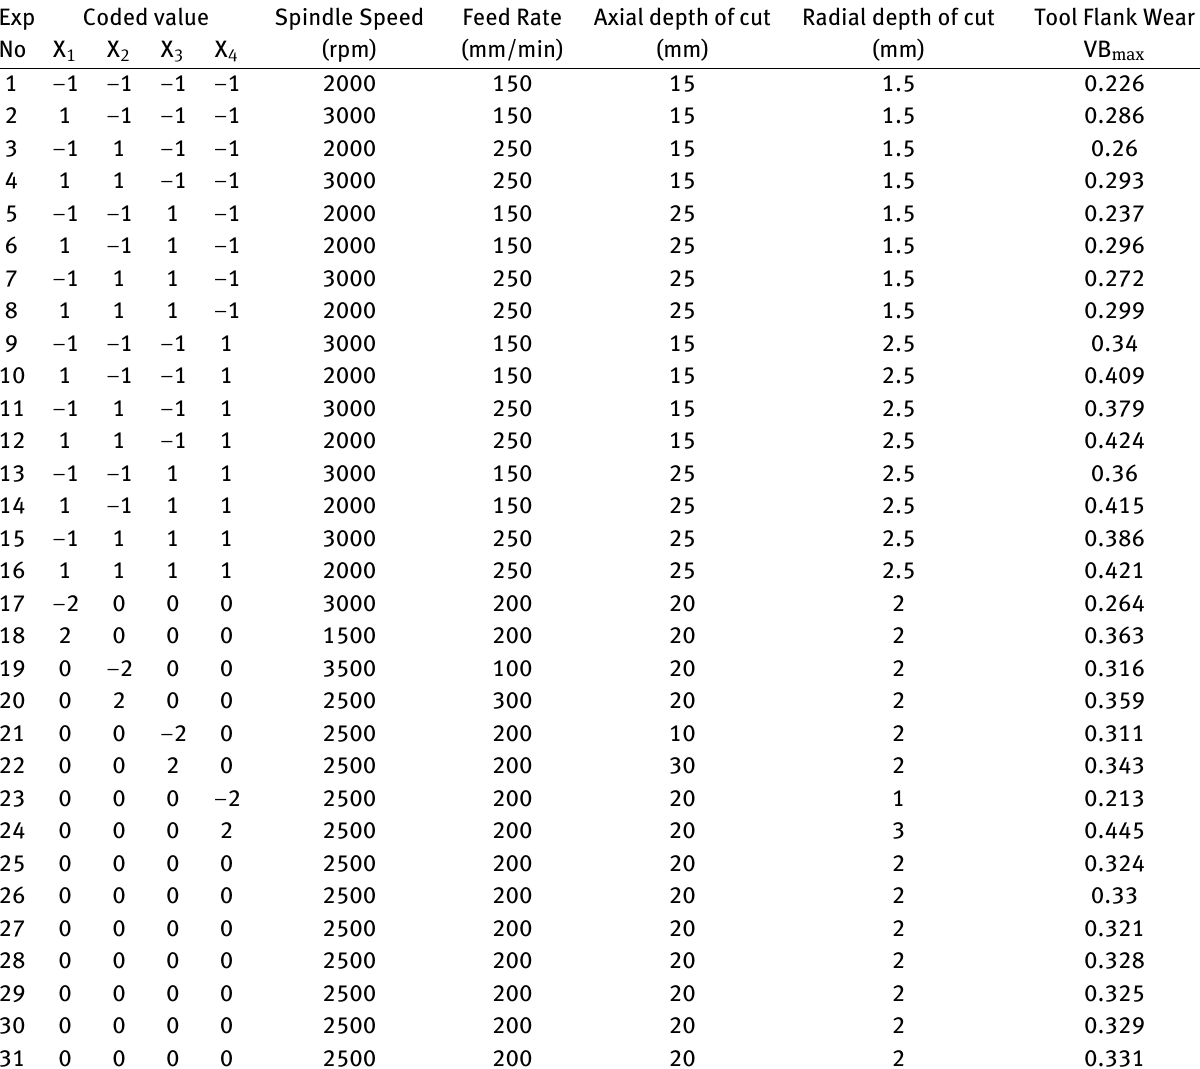
Table 4: Design matrix and experimental results.